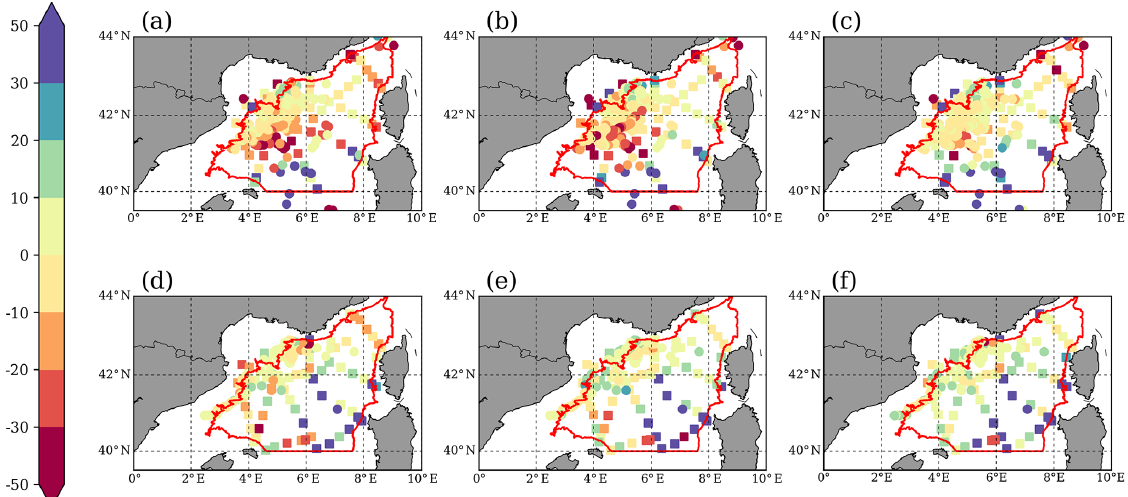
Figure 9. Bias of the stratification index relative to 1000m calculated for each simulation – (a, d) COARE, (b, e) ANDREAS and (c, f) MOON – during the (a–c) DEWEX leg 1 cruise and (d–f) DEWEX leg 2 cruise. Red line: convective area defined in Sect.